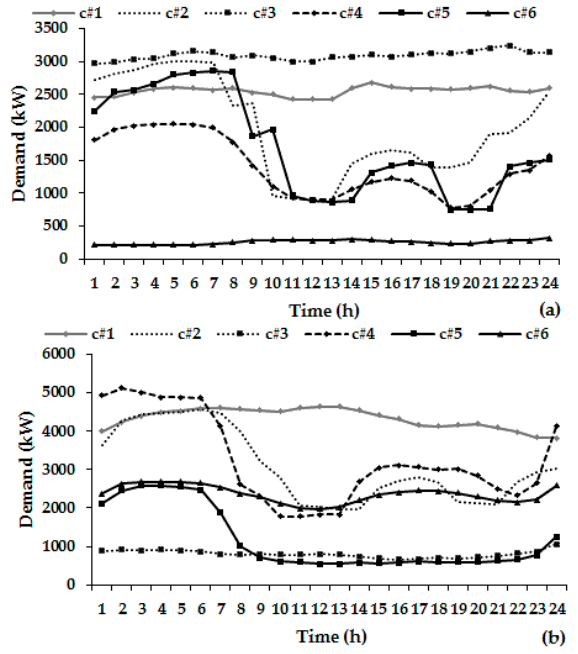
Figure 9. Load profiles of ( a ) consumer 1 and ( b ) consumer 2.